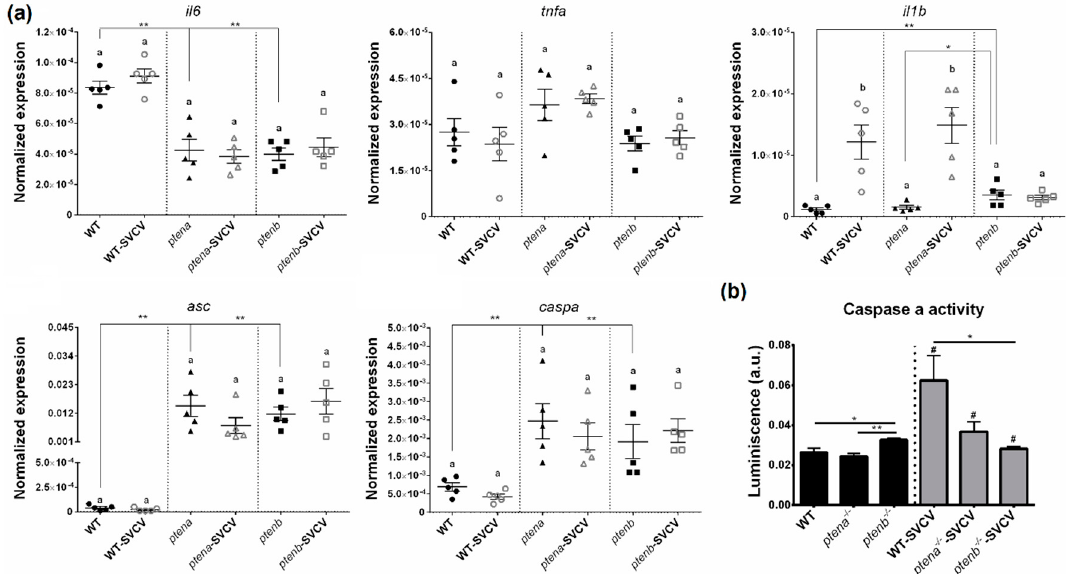
Figure 7. Mutations in the pten genes alter the inflammation-related gene expression and inflammasome activity. ( a ) Expression of pro-inflammatory cytokines and inflammasome components in the WT and pten mutant zebrafish larvae under healthy and SVCV-infected conditions. The expression of the different genes was normalized to the expression of the 18S ribosomal RNA gene. The graphs represent the means ± SEMs of 5 biological replicates. Statistically significant differences between the uninfected and SVCV-infected individuals from the same zebrafish line are represented with different letters, whereas differences among the zebrafish lines are represented with asterisks as follows: ** (0.001 < p < 0.01) or * (0.01 < p < 0.05) ( b ) Measurement of caspa activity in the WT, ptena -/- , and ptenb -/- larvae exposed or not to SVCV bath challenge for 24 h. The graphs represent the means ± SEMs of 5 biological replicates (10 larvae/replicate). Statistically significant differences between the uninfected and SVCV-infected individuals from the same zebrafish line are represented with hashes ( # (0.01 < p < 0.05)), whereas differences among the zebrafish lines are represented with asterisks (** (0.001 < p < 0.01) or * (0.01 < p < 0.05)).